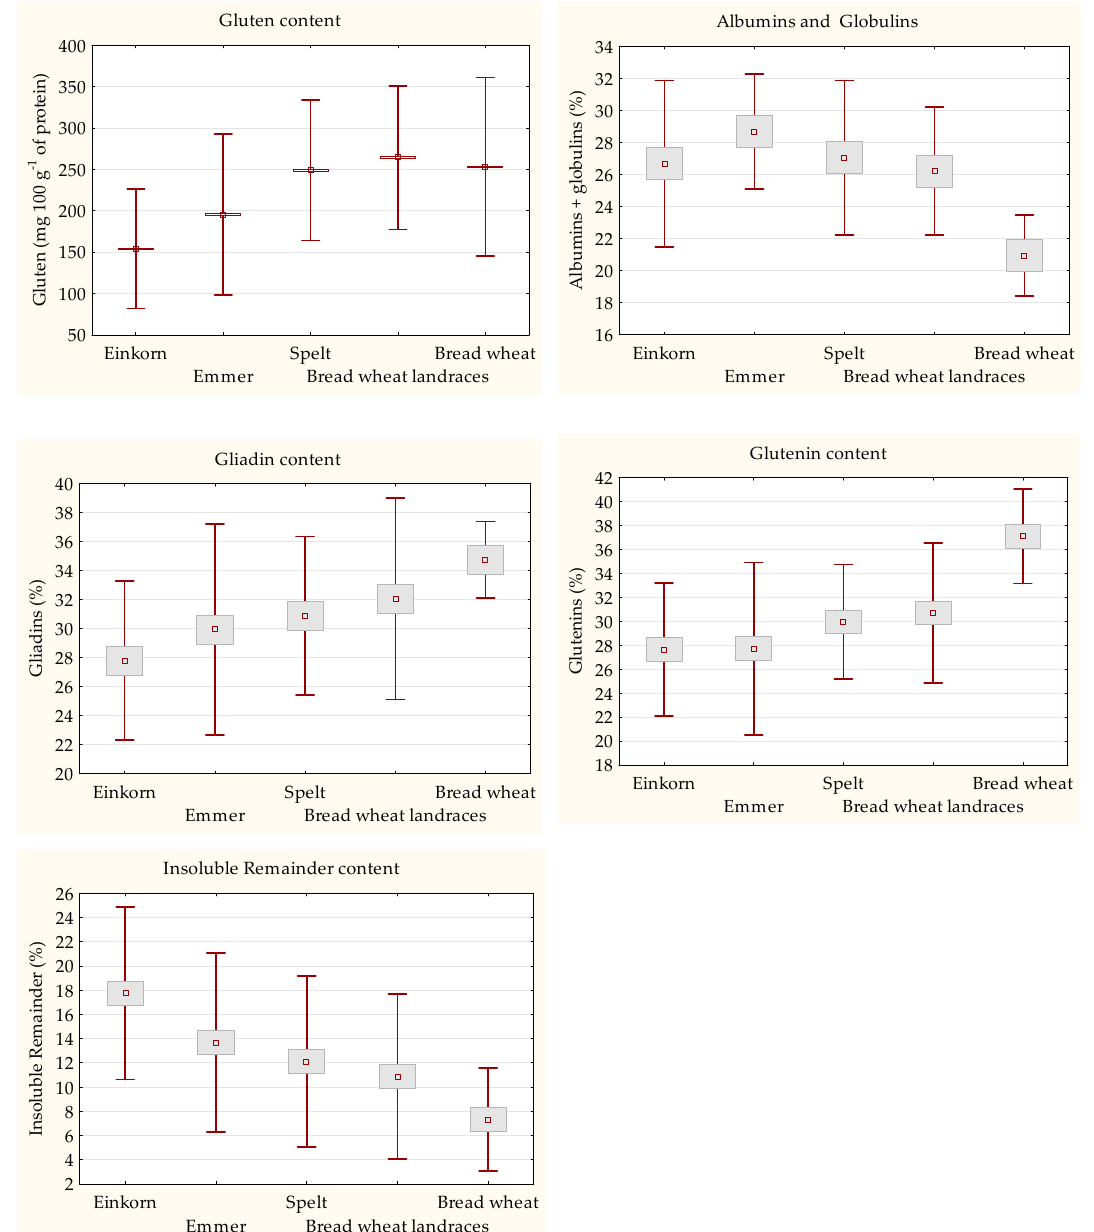
Figure 4. Contents of gluten, albumins and globulins, gliadins, glutenins, and insoluble remainder. The figures are presented as means of five wheat species grown at three locations, three replications, in four years ( n = 936). Box plots represent the interquartile range, the rectangles in the box symbolize the mean value ± 1, and whiskers designate the minimum and maximum of the box plot.